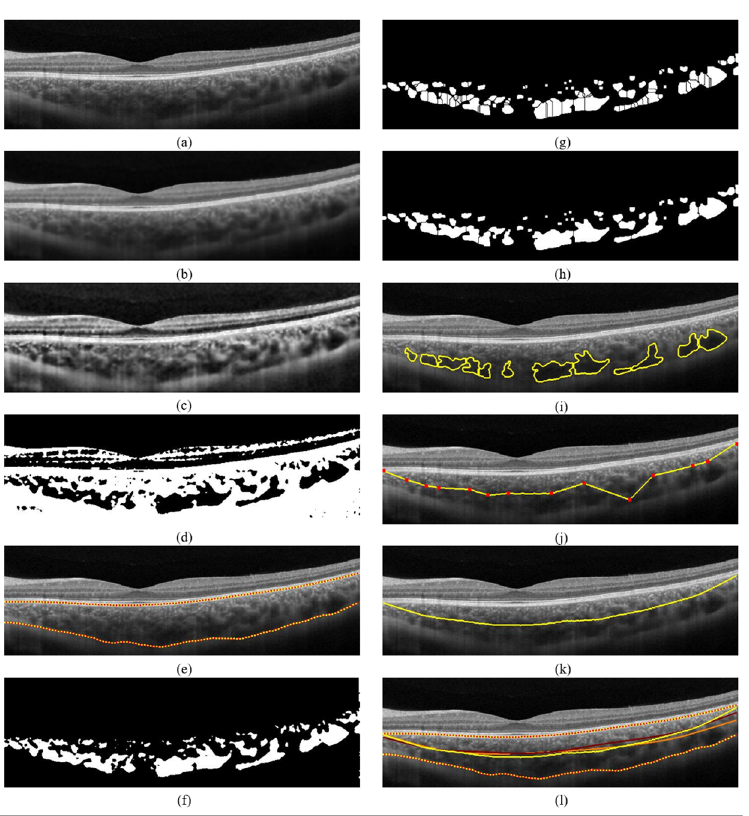
Fig 3. Proposed algorithm depicted graphically. (a) Raw OCT B-scan; (b) Denoised using Wiener filter; (c) Adaptive histogram equalized image; (d) Binarized image [30]; (e) Detected choroid boundaries [27]; (f) Binarized choroid layer (inverted); (g) Watershed segmentation; (h) Watershed segmentation post extended-minima; (i) Large vessel boundaries; (j) Innermost (linear interpolated) points of the vessels; (k) Smoothened Haller’s layer boundary; and (l) Algorithmic (yellow) vs (orange and red) manual